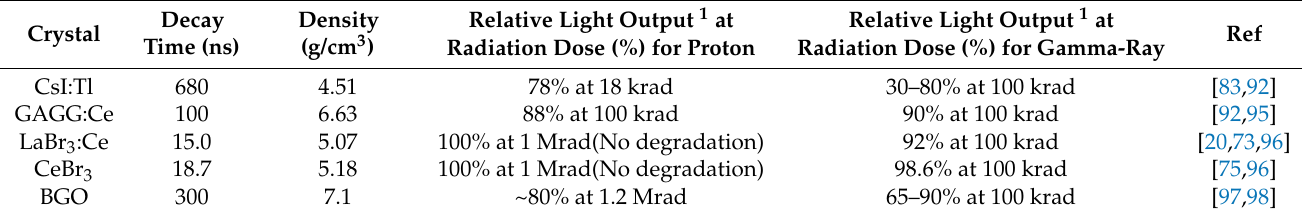
Table 5. Performances of reported scintillators and critical parameters for space